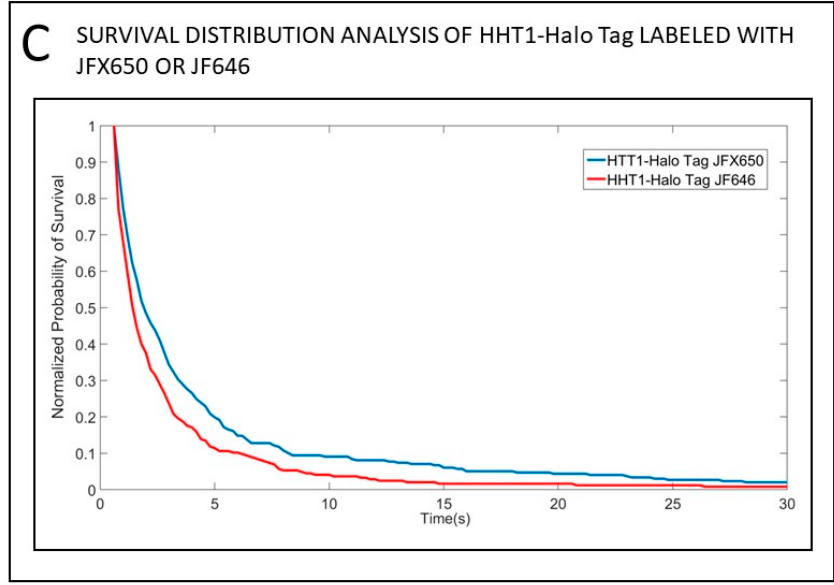
Figure 1. Staining for SMT in yeast. ( A ) Optimization of the dye retention by KO of the multidrug resistance transporter PDR5 . A HILO-illuminated field of view for pdr5 homozygotes (left) and heterozygotes (right) stained for RPO21 -HaloTag (the largest subunit of RNA Pol II) with 10 pM of JFX 650 ligand. Traces of single molecules are superimposed on the first frame of the movie. ( B ) Molecule survival in the field of view. Left: kymograph (X/T/Maximum intensity Y projection) of a single movie containing 10 nuclei of HHT1 -HaloTag (yeast histone H3 protein) labeled with 1 pM of JFX 650 . Red rectangle with blue arrow indicates a bound molecule on the kymograph. Right: Schematics of survival of the molecules (red circles). Ten molecules are identified in frame t 0 . They may disappear in subsequent frames due to photobleaching or diffusion. The number of molecules visible at each time point may be plotted over time after normalization. ( C ) The choice of dye impacts the length of observation. Survival distribution for HHT1 -HaloTag stained with 1 pM of JFX 650 (blue) or JF 646 (red) ligand. The curves are normalized to the total number of molecules observed in the first frame, and thus they are not dependent on the initial concentration of labeled molecules. The total number of HHT1p molecules detected by JFX 650 Halo Tag ligand was 9214 and 5179 by JF 646 per 149